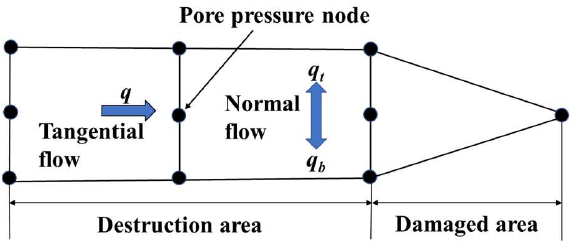
Figure 2. The fluid flow schematic within a damaged unit.